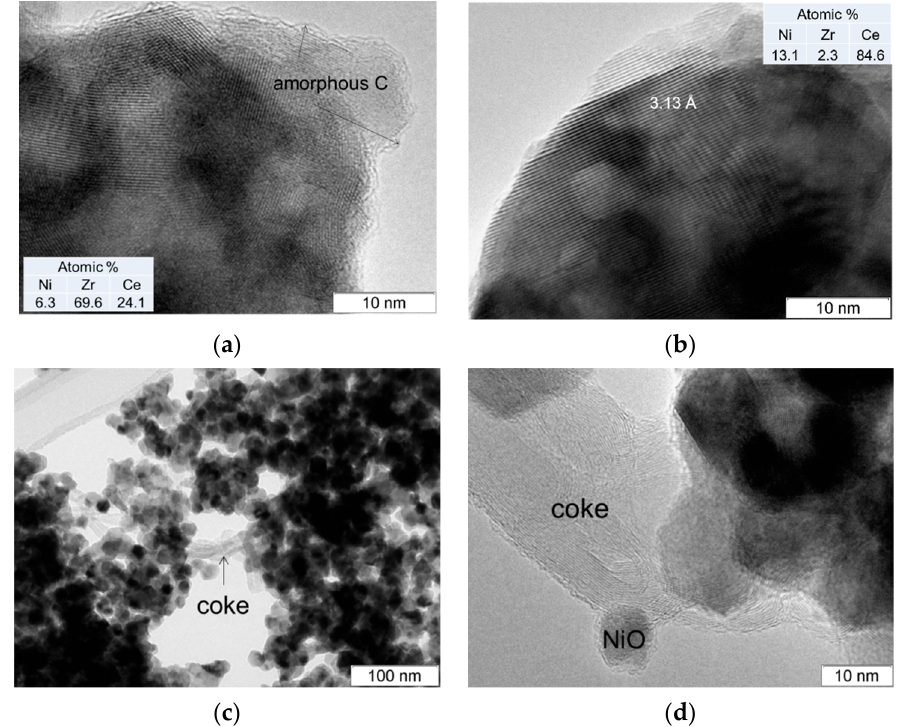
Figure 14. TEM images of Ni-Ce x Zr 1 − x catalysts after reaction: ( a ) Ni-Ce 0.3 Zr 0.7 op; ( b ) Ni-Ce 0.7 Zr 0.3 op; ( c, d ) Ni-Ce 0.7 Zr 0.3 im.